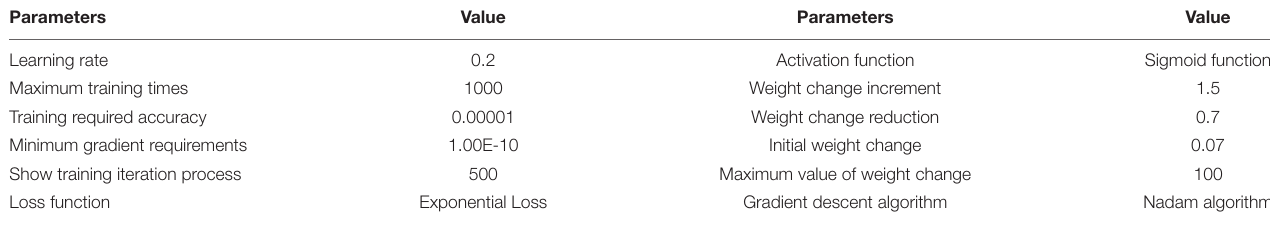
TABLE 2 | Hyperparameter setting of